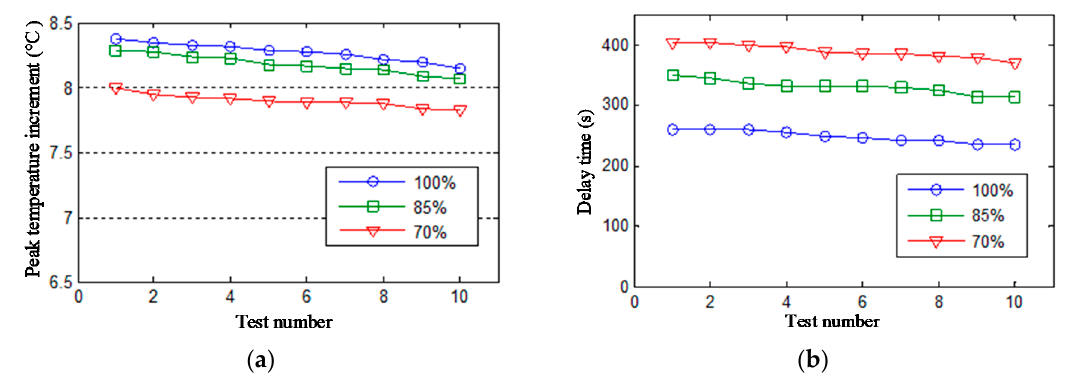
Figure 15. Ten 10 times test results vary with three connection areas: ( a ) peak temperature increment; ( b ) delay time to peak temperature. ( b ) delay time to peak